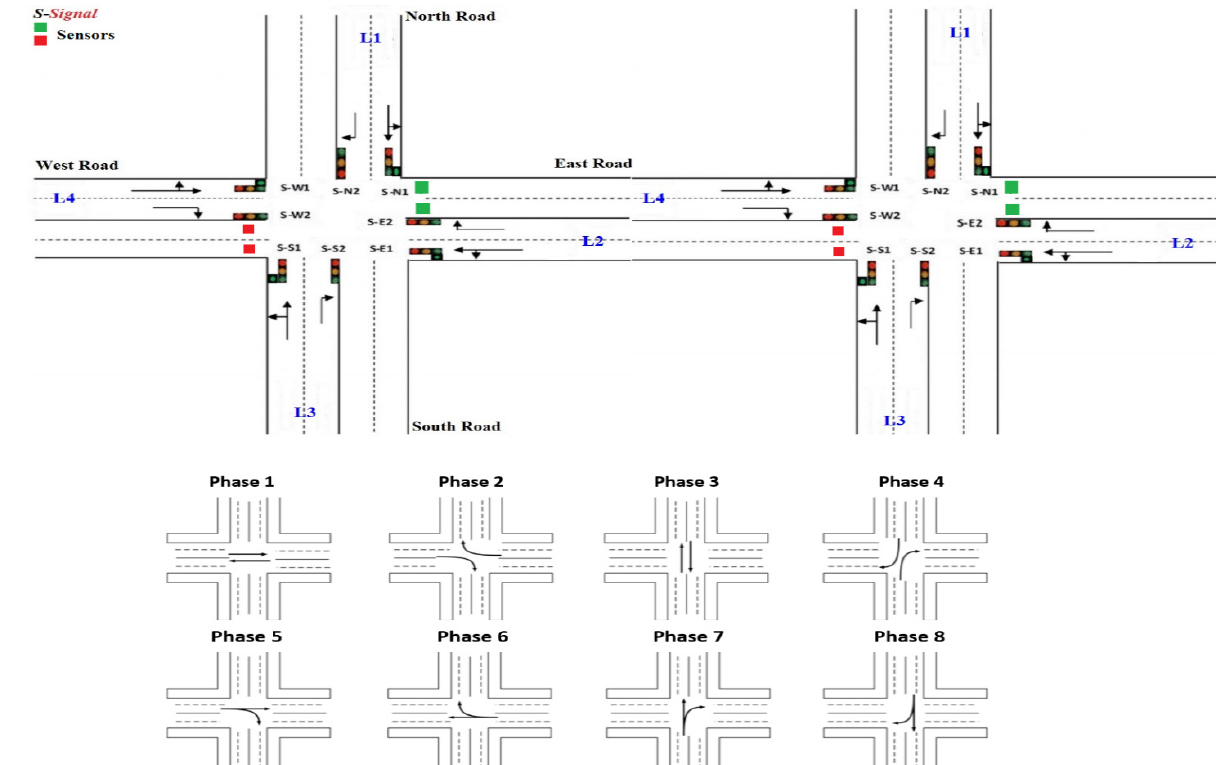
Figure 5. IoT-based mechanism for traffic signal synchronization using sensor deployment on adjacent junctions [74].